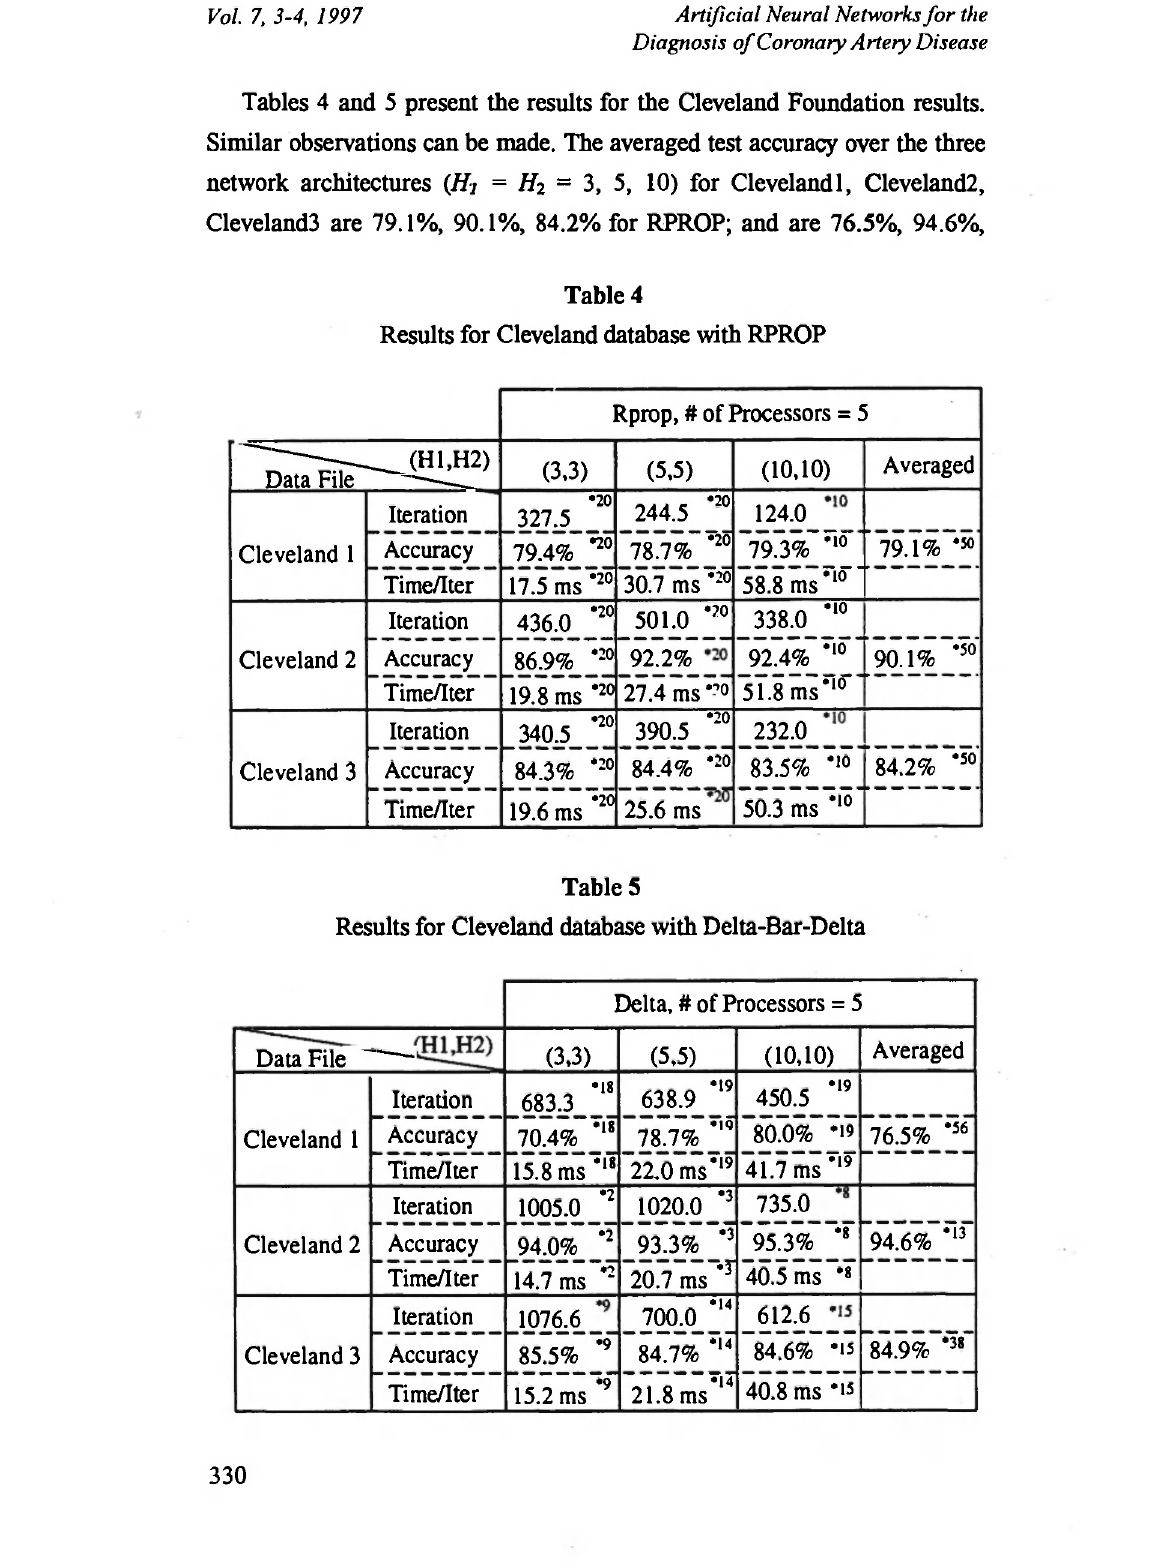
Results for Cleveland database with RPROP